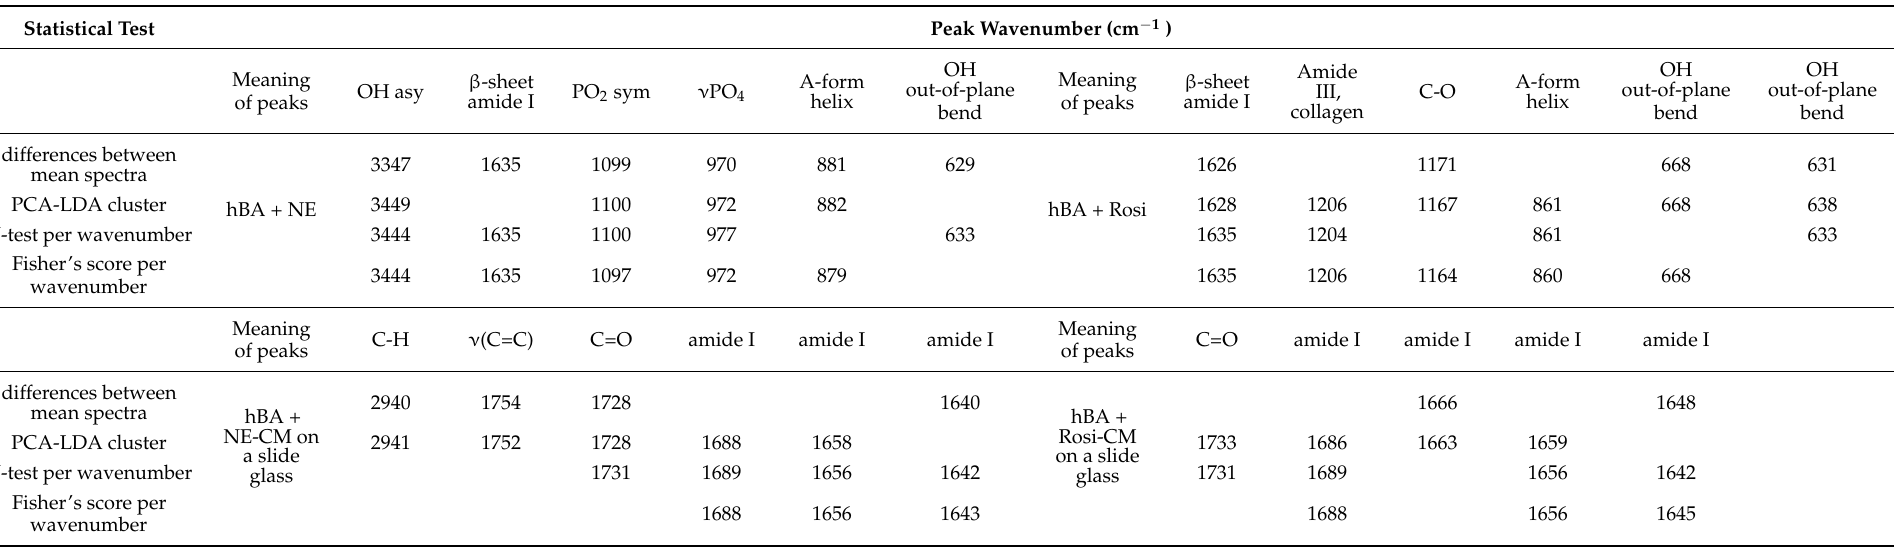
Table 4. Infrared spectral biomarkers for browning in human adipocytes in adipocyte/conditioned